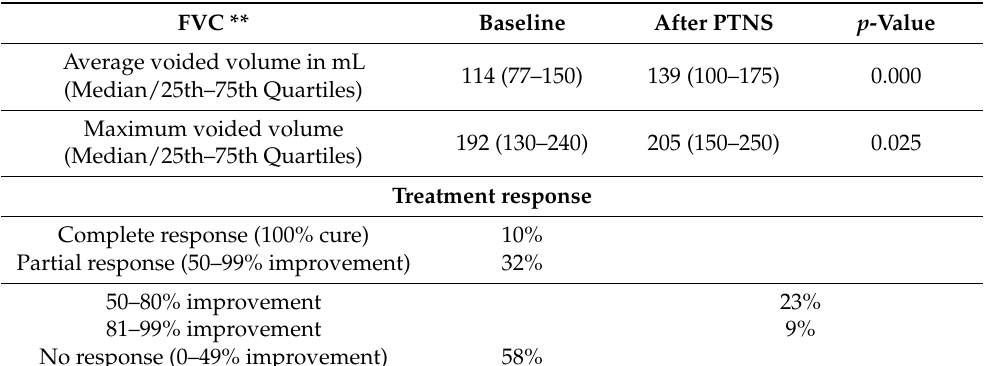
Table 1. Frequency voiding chart parameters and treatment response according to the ICCS *.